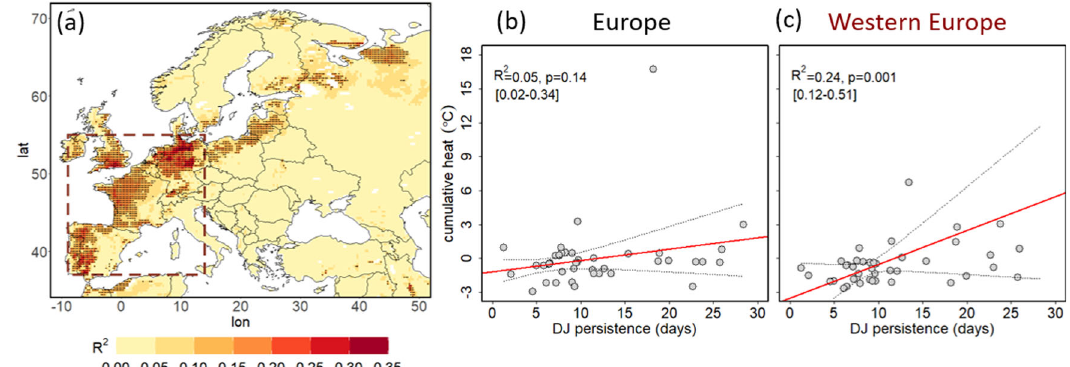
Fig. 5 Explained variance of heatwave cumulative intensity by double jet persistence. a Explained variance (R 2 ) per grid point of heatwave cumulative intensity based on linear regression on double jet persistence. Statistically signi fi cant coef fi cients ( p < 0.05) are marked with black dots. b Scatter plots of heatwave cumulative intensity anomalies aggregated over all land grid points of the extended European domain (as seen in panel a and in the red dashed box of Fig. 1a, b) and double jet persistence. A linear fi t (in red) and its con fi dence interval (dashed lines for the 5th and 95th percentiles obtained from 1000 bootstraps), R 2 (with 5th and 95th interval percentiles obtained from 1000 bootstraps in brackets), and p -values are shown on the top left of each plot. c As for b but with heatwave cumulative intensity aggregated only over land grid points with statistically signi fi cant coef fi cients in western Europe (dotted points in panel a within the region included in the dashed red box: 37 – 55 ˚ N and 9 ˚ W – 14 ˚ E). The linear trend of the time series was removed before the regression was applied in all cases.